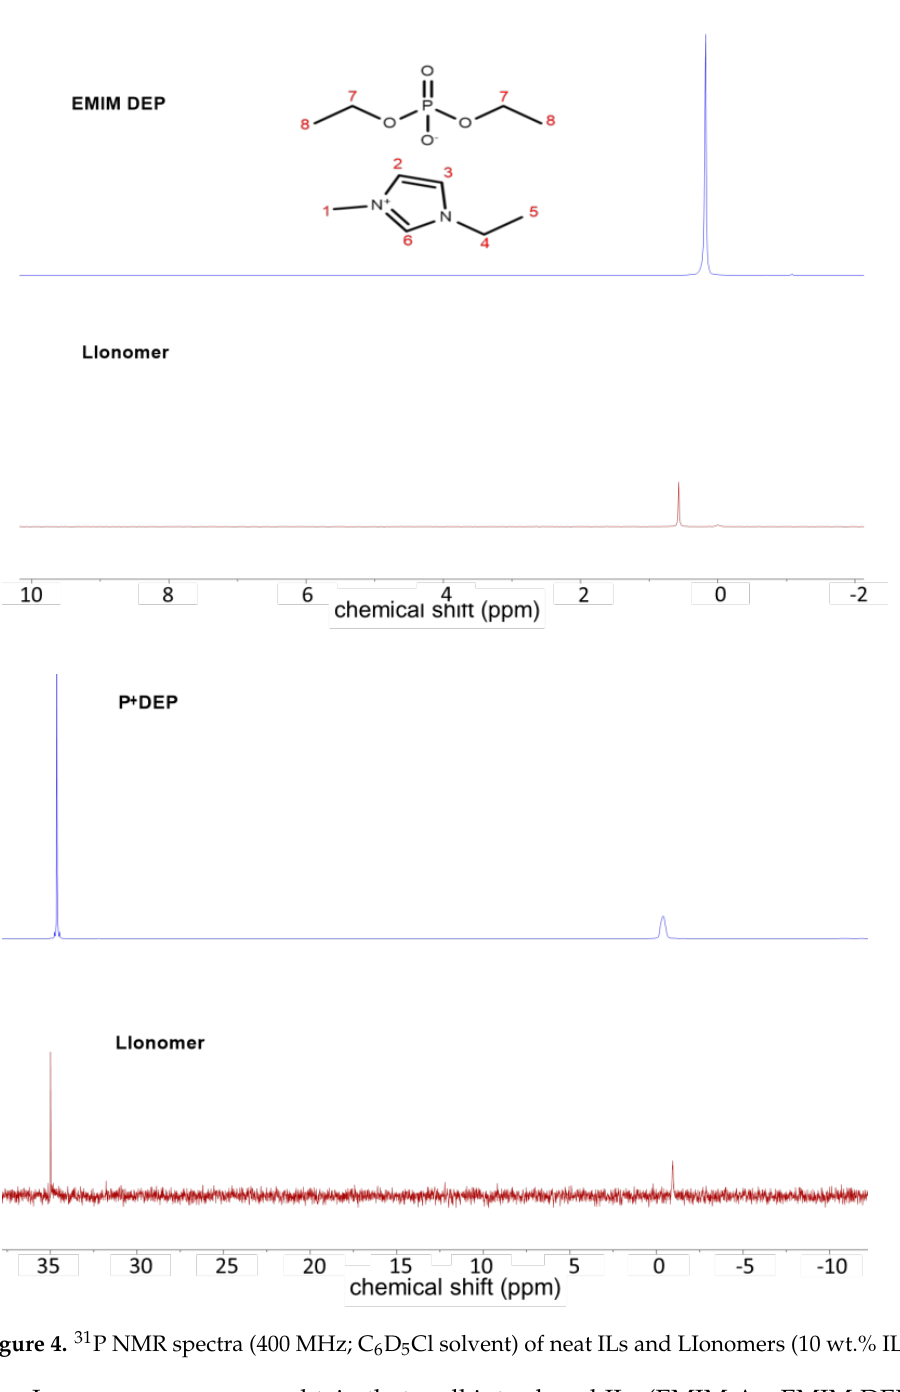
Figure 3. 1 H NMR spectra (400 MHz; C6D5Cl solvent) of ILs and related LIonomers materials (10 wt.% IL).